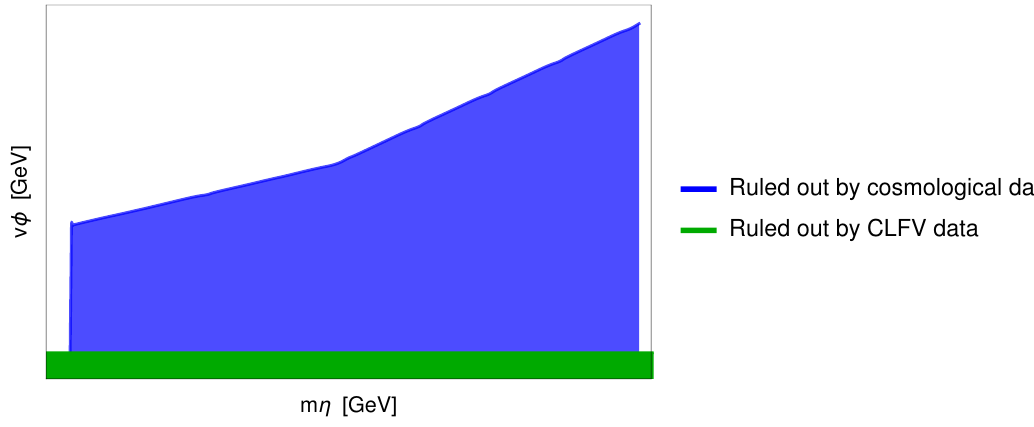
Figure 7 . Regions ruled out in the m (cid:17) - v (cid:30) plane, due to the constraints from CMB data and small scale structure observations, in blue, and from CLFV experiments, in